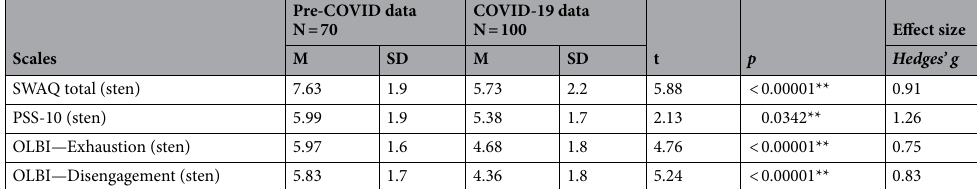
Table 3. Comparison of the results obtained prior to and during the COVID-19 pandemic (independent samples Student’s t -test). SWAQ the Subjective Work Assessment Questionnaire, PSS-10 the Perceived Stress Scale, OLBI the Oldenburg Burnout Inventory. **Statistically significant values p < 0.05.